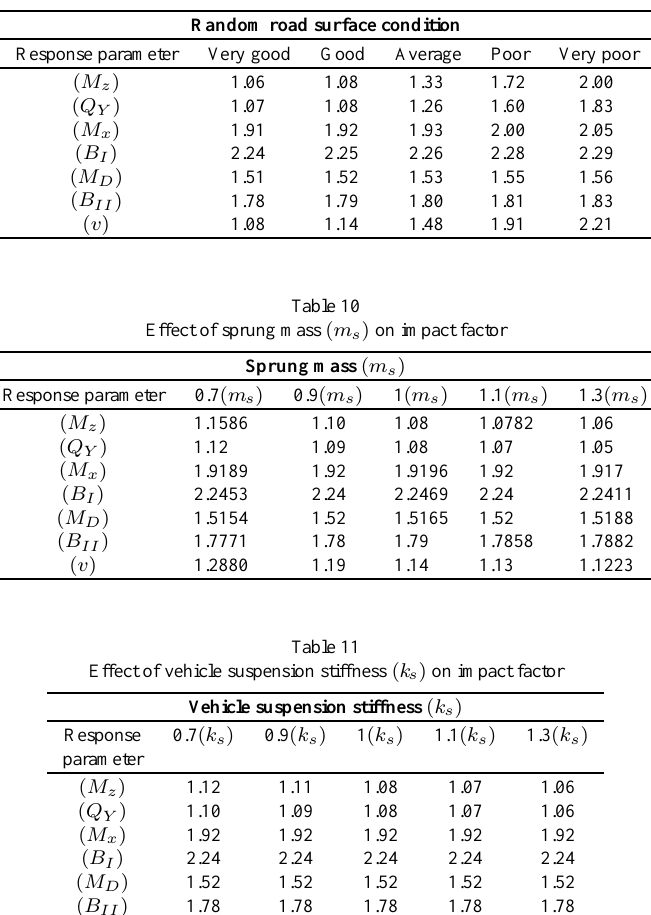
Table 9 Effect of random road surface condition on impact factor